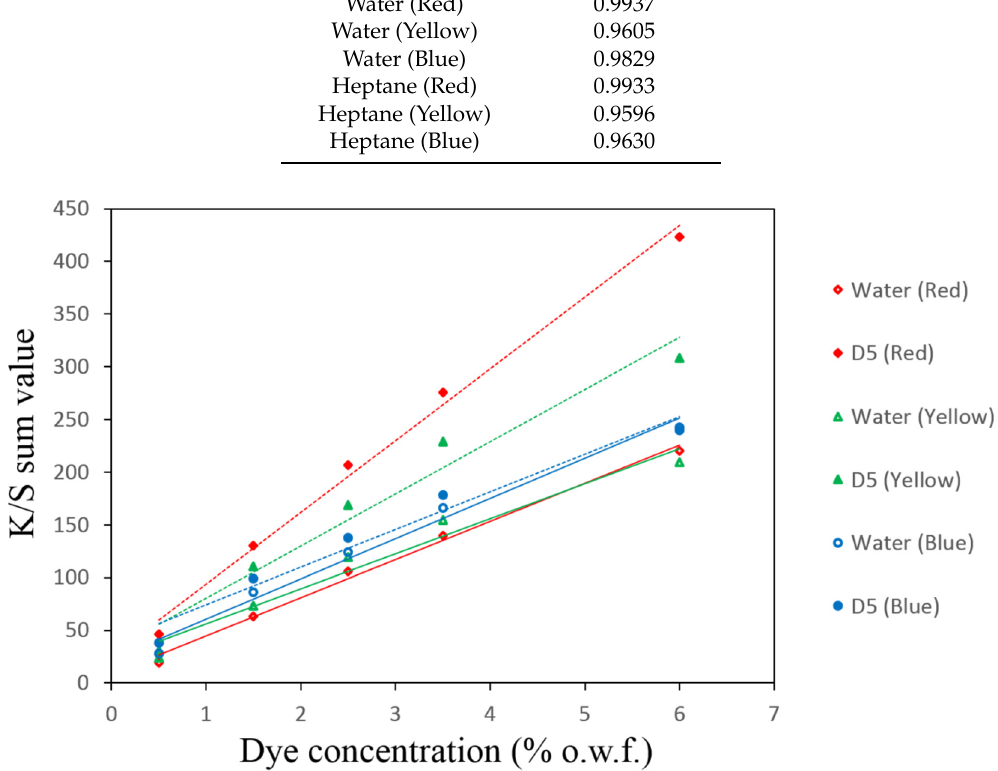
Figure 7. Calibration curves of the primary colors of batch samples dyed in water and D5 for color matching. Table 5. The R ‐ square value of the dyeing method of three primary colors.